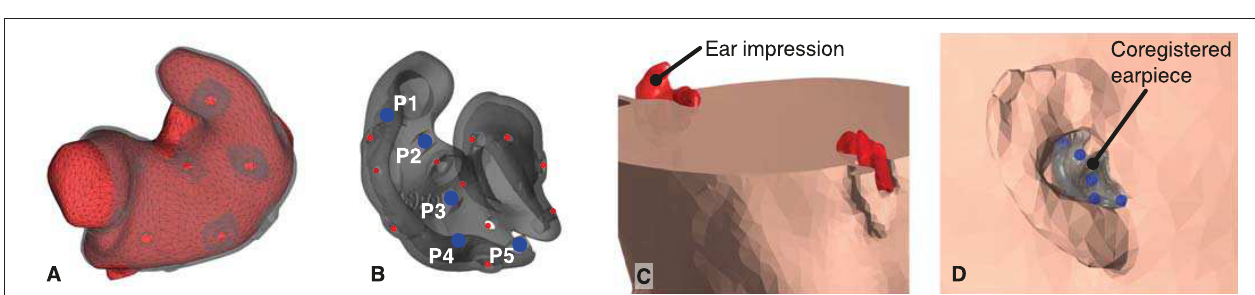
FIGURE 3 | (A) 3D scanned ear impression for the right ear with overlay of the ear-EEG earpiece. (B) Ear-EEG earpiece for the right ear. Blue dots indicate the fiducials P1-P5 on the earpiece, red dots indicates the location of electrodes. (C) . Cross section of the head mesh grid, showing the subtraction of the ear impressions. (D) The earpiece placed in the scalp mesh grid of the